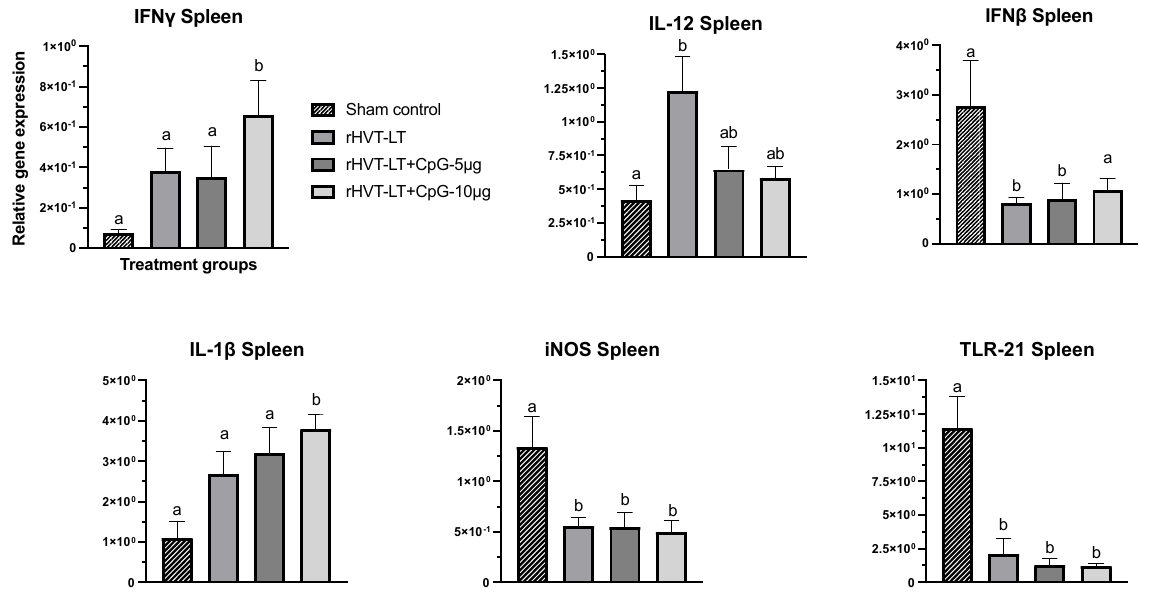
Figure 2. Effect of CpG-ODN adjuvantation on the immune-gene expression in the spleen. Recom- binant HVT-LT (rHVT-LT) vaccine was adjuvanted with either 5 μ g or 10 μ g of CpG-ODN and administered in ovo on the day 18 of embryonation (ED18) via the amniotic route. Spleens from the day-old broiler chicks were collected in RNAlater for RNA extraction and cDNA synthesis. Real- time PCR to quantify the expression of IFN γ , IL-12, IFN β , IL-1 β , iNOS (inducible nitric oxide syn- thase), and TLR21 genes was performed along with the housekeeping gene ( β -actin). The expression levels are shown as relative to β -actin. Different letters above the standard-error-of-mean bars indi- cate significant difference ( p < 0.05) between the groups. In the lung (Figure 3), the expression of IFN γ in the chicks receiving rHVT-LT + CpG ODN-10 ug was higher ( p < 0.05) than the rest of the treatment groups, while the iNOS transcription in these birds was also found increased ( p < 0.05) when compared to those administered rHVT-LT + CpG ODN-5 ug. Like in the spleen, the TLR21 expression in the lung of all the treatment groups was found reduced ( p < 0.05) in comparison to the sham, while the transcription of IL-1 β in the rHVT-LT or rHVT-LT + CpG ODN-5 ug groups was decreased ( p < 0.05) than the groups that received sham or rHVT-LT + CpG ODN-10 ug. Furthermore, the birds receiving rHVT-LT + CpG ODN-5 ug also had reduced ( p < 0.05) expression of IL-12 than the rest of the groups. However, no significant changes in the expression of IFN β was observed between the treatment groups.